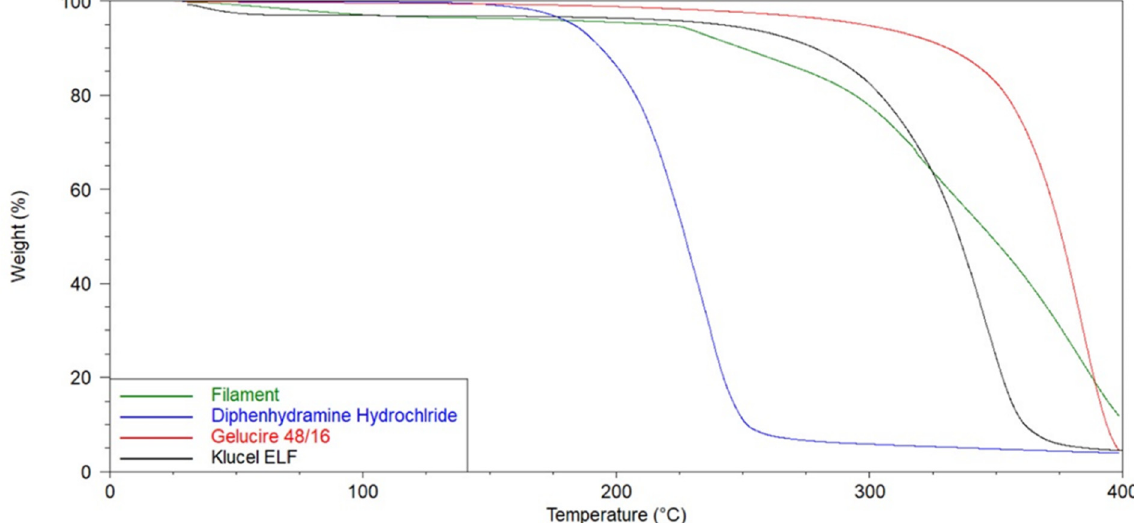
Figure 2. TGA thermograms of Klucel ELF TM , Gelucire 48/16 TM , diphenhydramine hydrochloride and drug loaded filament.